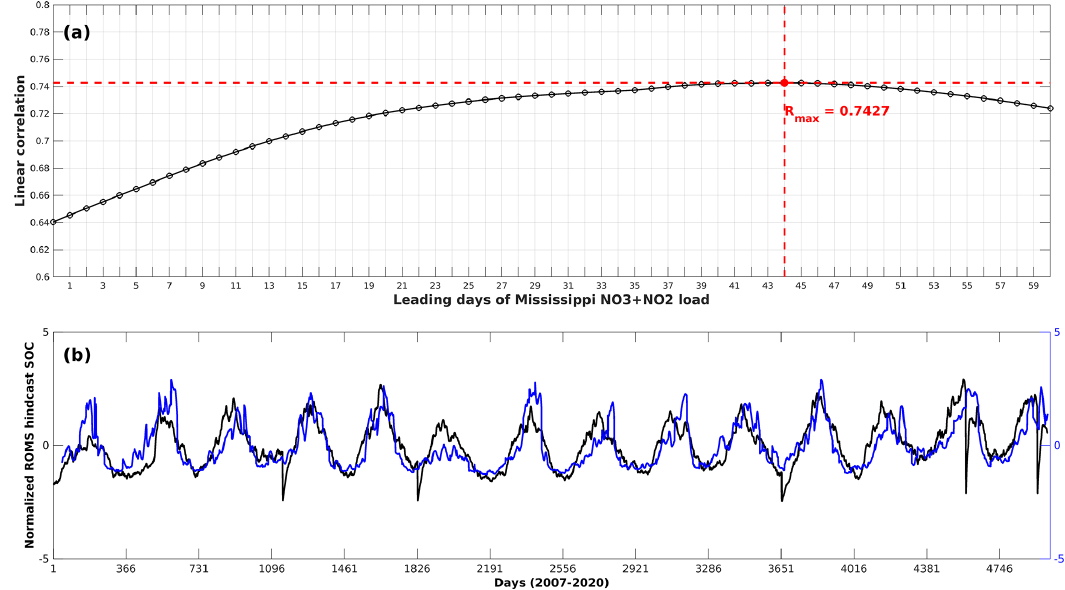
Figure A3. (a) Lead–lag correlation coefficients between ROMS-hindcast daily SOC and SOCalt (Mississippi River inorganic nitrogen loads · e 0 . 0693 T b ) with the Mississippi nitrogen loads leading by different days; (b) daily time series of ROMS-hindcast SOC and SOCalt when the Mississippi nitrogen loads lead by 44d. The time series are regional average results over the LaTex shelf and are normalized.